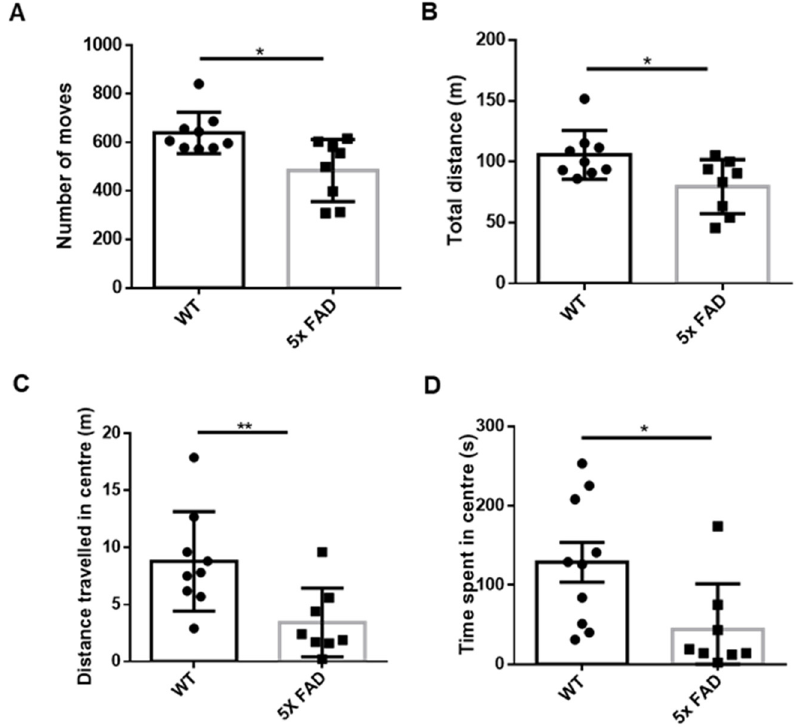
Figure 1. Enhanced anxiety in 2 mo 5 × FAD mice at early neurodegenerative stage . ( A ) Total number of moves; ( B ) total distance traveled; ( C ) distance traveled in the center; and ( D ) time spent in the center of an open field were measured. The 5 × FAD mice showed reduced stay in the central zone compared to WT littermates ( n = 8–10). Data expressed as mean ± SEM; * p < 0.05, ** p < 0.01 (Mann–Whitney test).